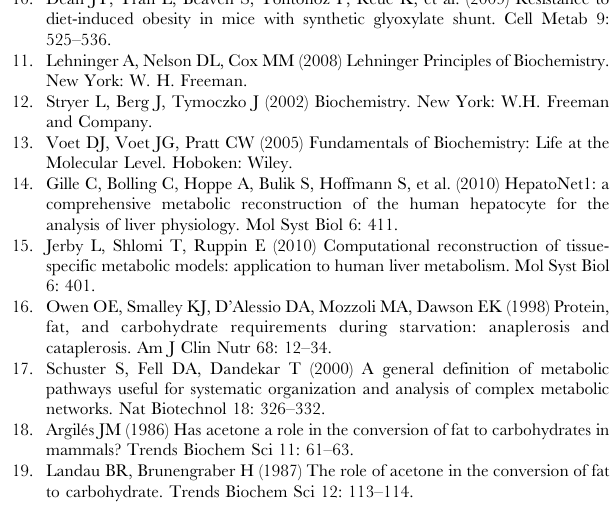
Table S1 List of metabolite and enzyme abbreviations. (PDF) Text S1 Supplementary material and methods.